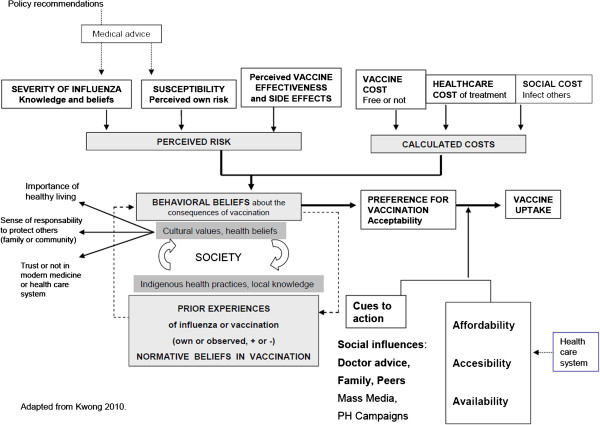
Factors affecting seasonal influenza vaccination in the elderly.